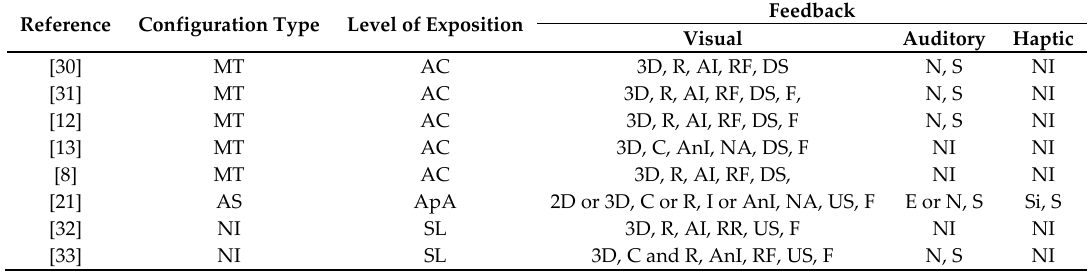
Table 1. Design features observed in the augmented reality systems for the treatment of small-animal